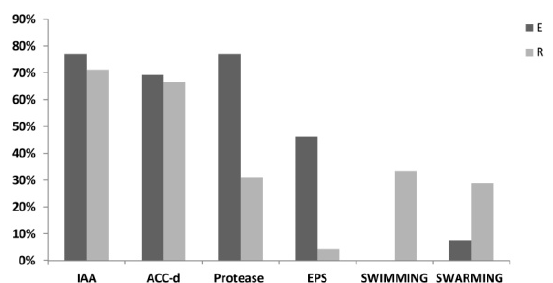
Figure 3. Characterization of the bacteria collection for plant growth promotion (PGP) traits. Percentage of strains isolated from endosphere (E, black) and rhizosphere (R, gray) fractions that resulted positive to PGP assays. Among PGP activities: IAA = indole-3-acetic acid production, ACC-d = ACC deaminase activity, Protease = protease production, EPS = exopolysaccharides production, SWIMMING = swimming lifestyle, SWARMING = swarming lifestyle.